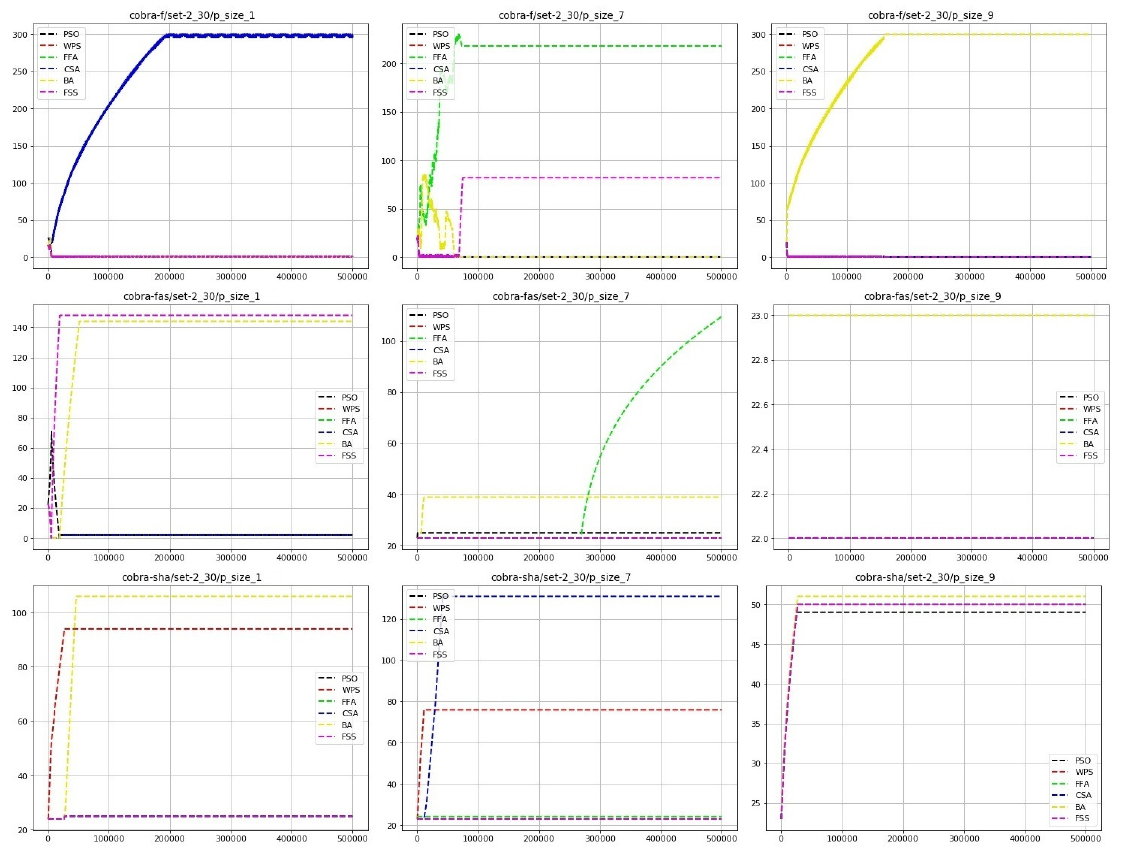
Figure 11. Population size changes for SET-2 with 30